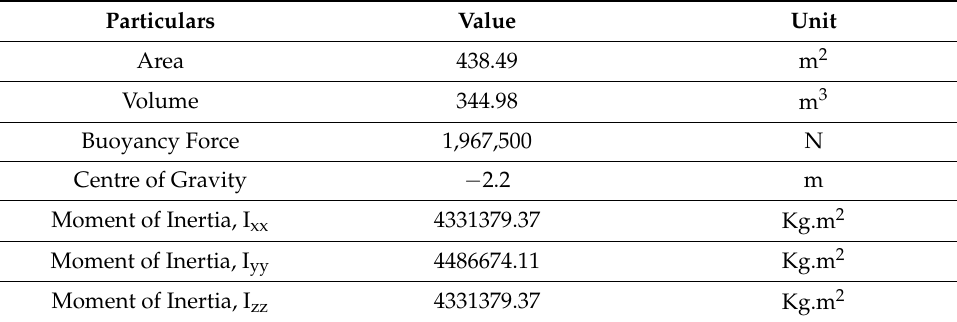
Table 13. Details for Buoy Hydrostatic